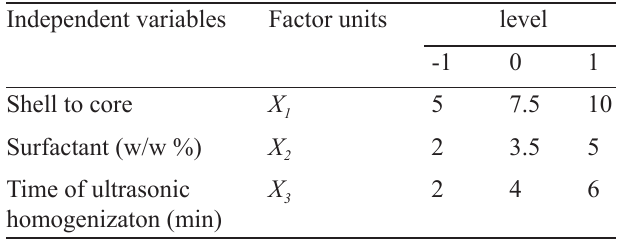
Table 2. Independent variables and coded values employed for optimization of the nanoparticle preparation